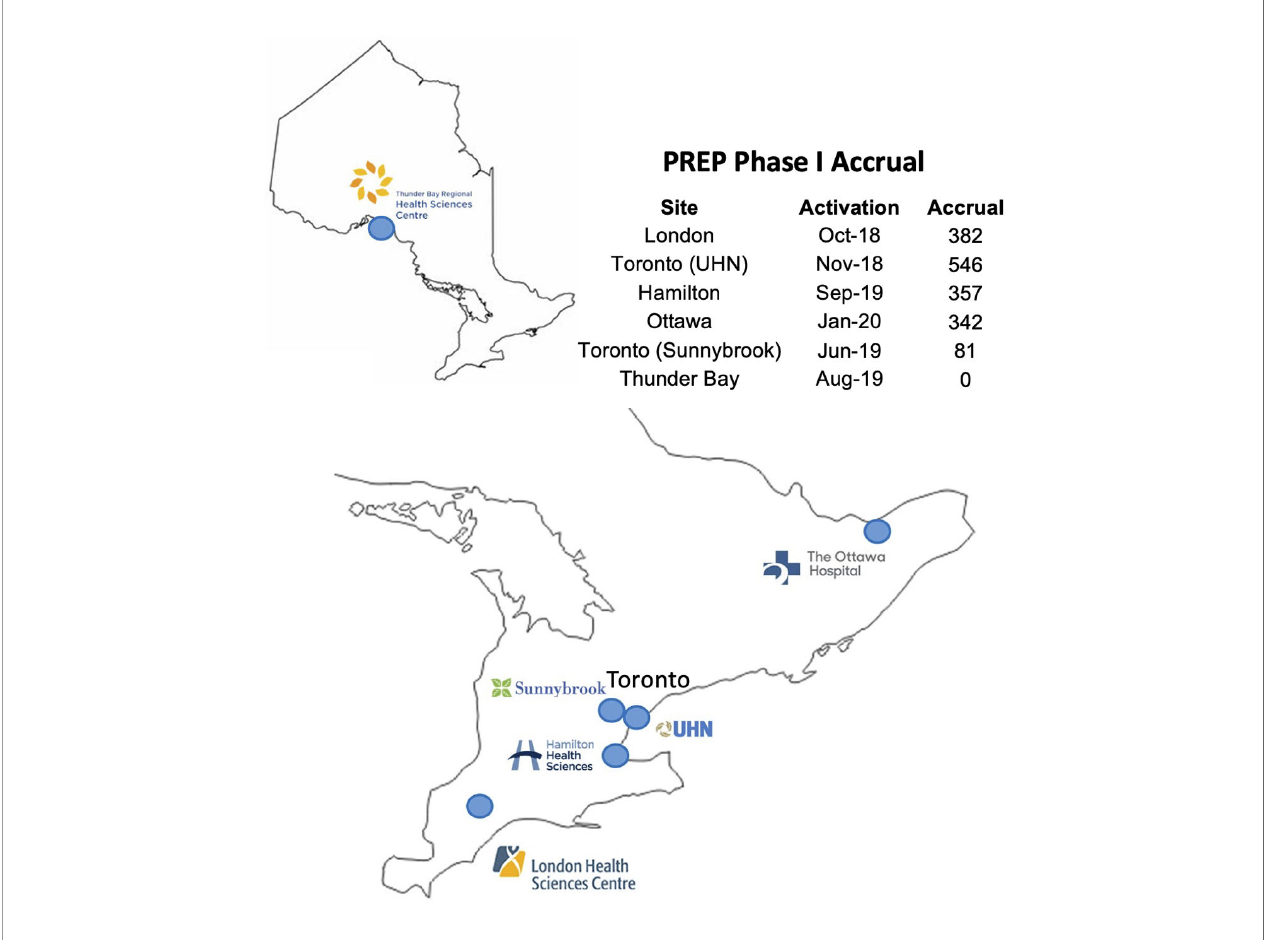
FIGURE 2 | Accrual by quarter across PREP